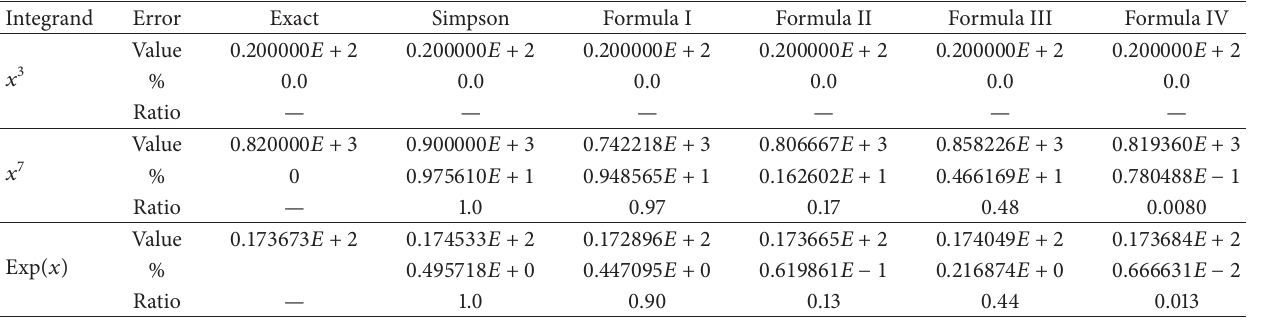
Table 7: Comparison of the integrals using four formulae of extrapolation methods (end-point Gauss quadrature) with Simpson’s 1/3 rule. Integrand